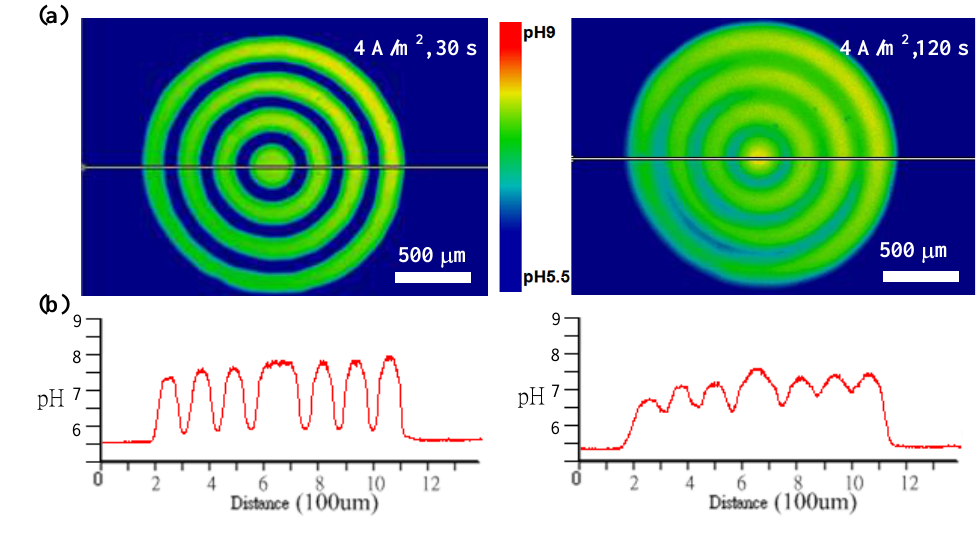
Figure 3. ( a ) The pH-dependent fluorescent images and ( b ) the cross-section profiles of the pH distribution in (a) when a patterned light illumination from DMD was projected onto a photoconductive substrate at an application of a current density of 4 A·m −2 for 30 s and 120 s,